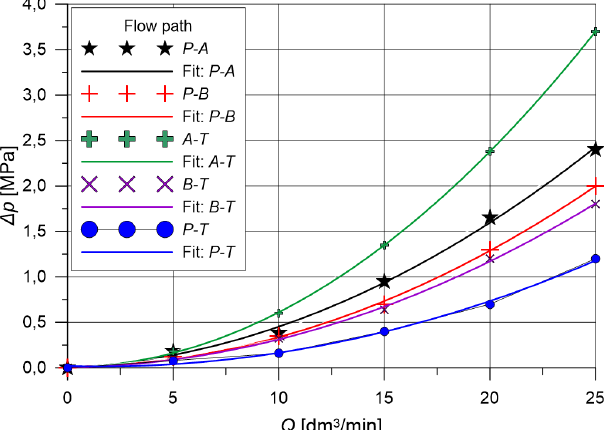
Figure 12. Pressure drop in individual flow paths (CFD analysis).